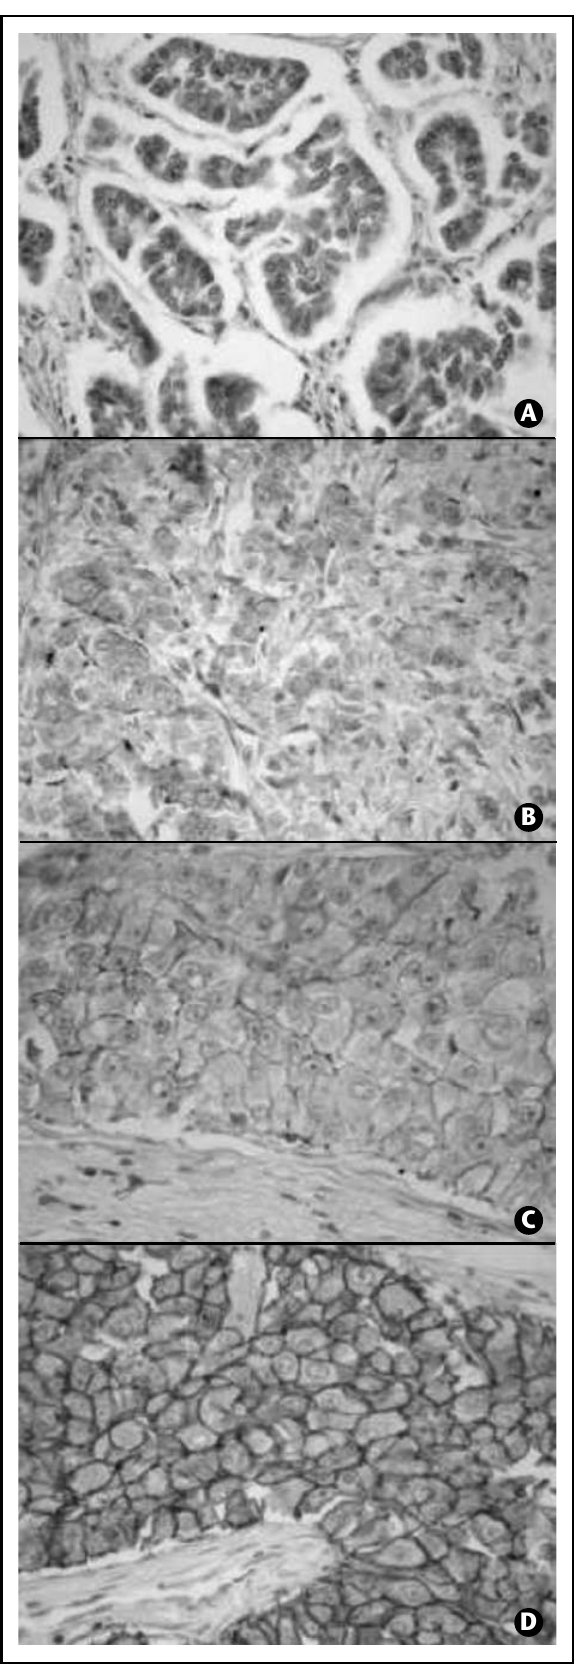
Figure 2 – Immunohistochemical staining carried out in our laboratory: Her2 staining using rabbit monoclonal SP3: 0 (A); 1+ (B); 2+ (C); 3+